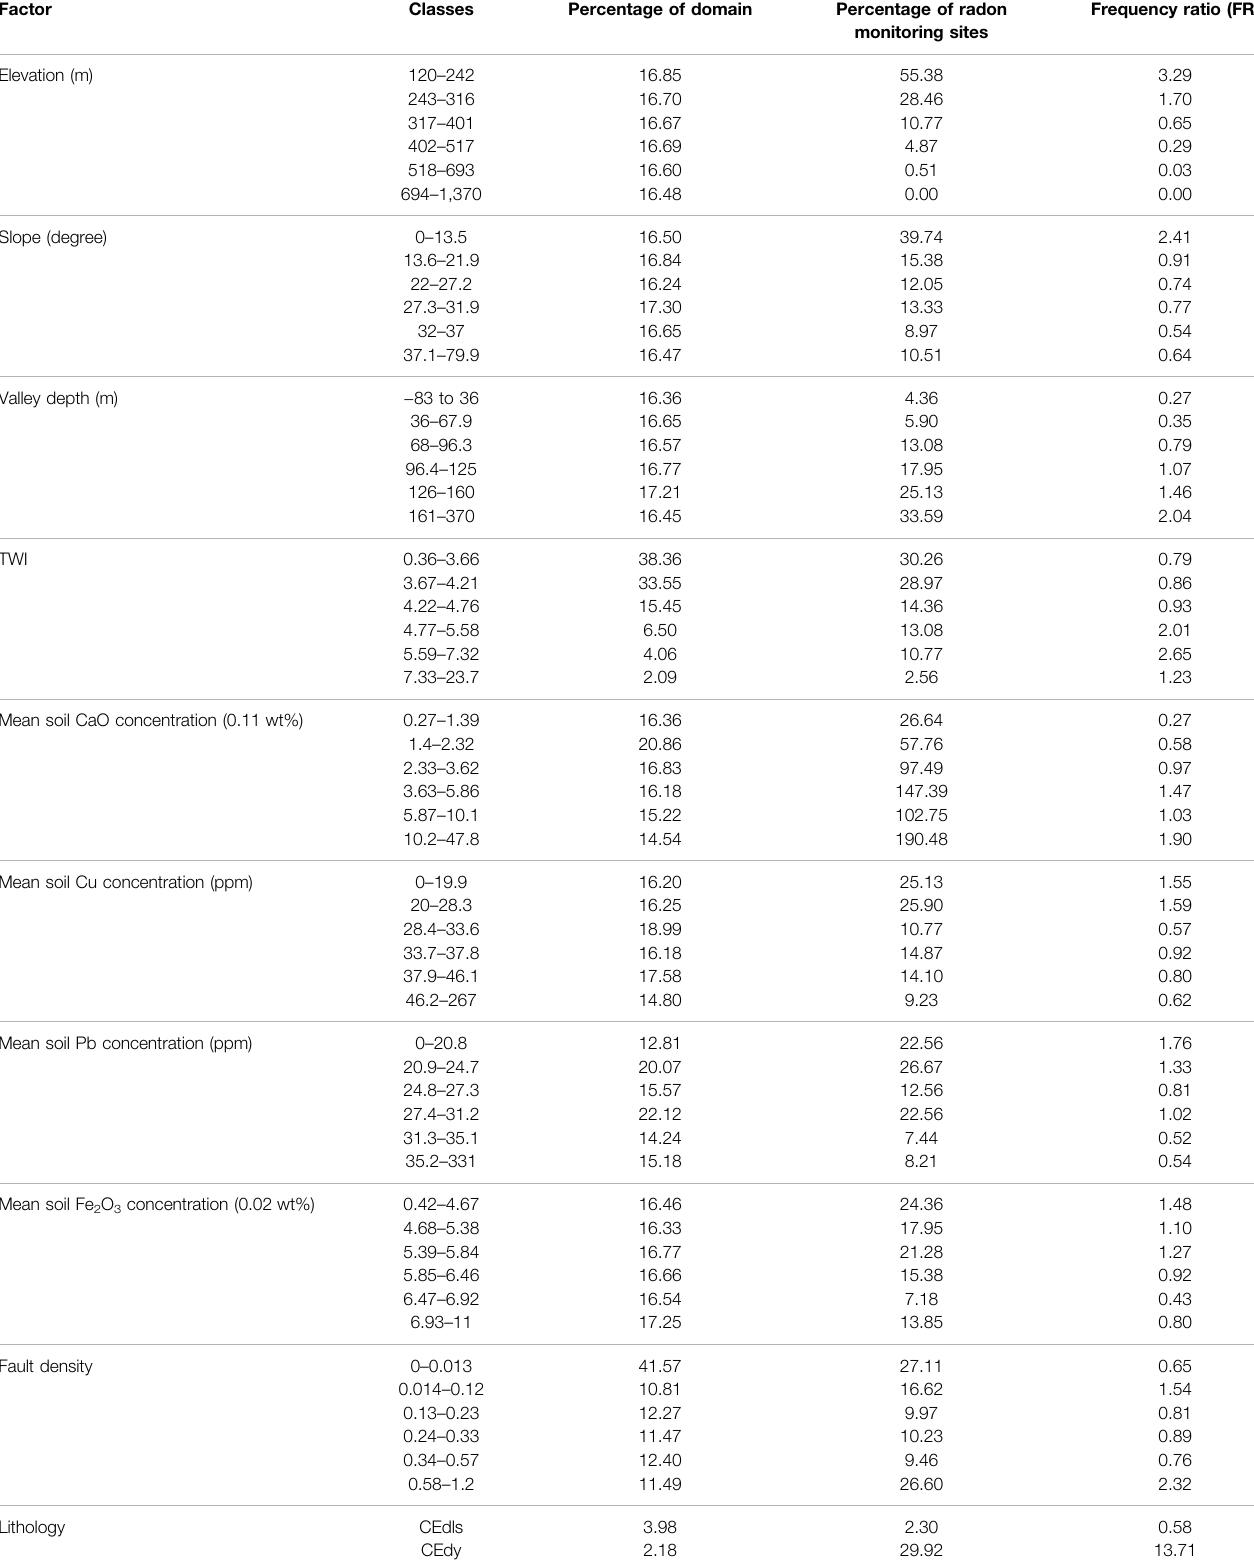
TABLE 3 | Spatial relationships of predictor variables with the IRC values, determined through FR analysis.